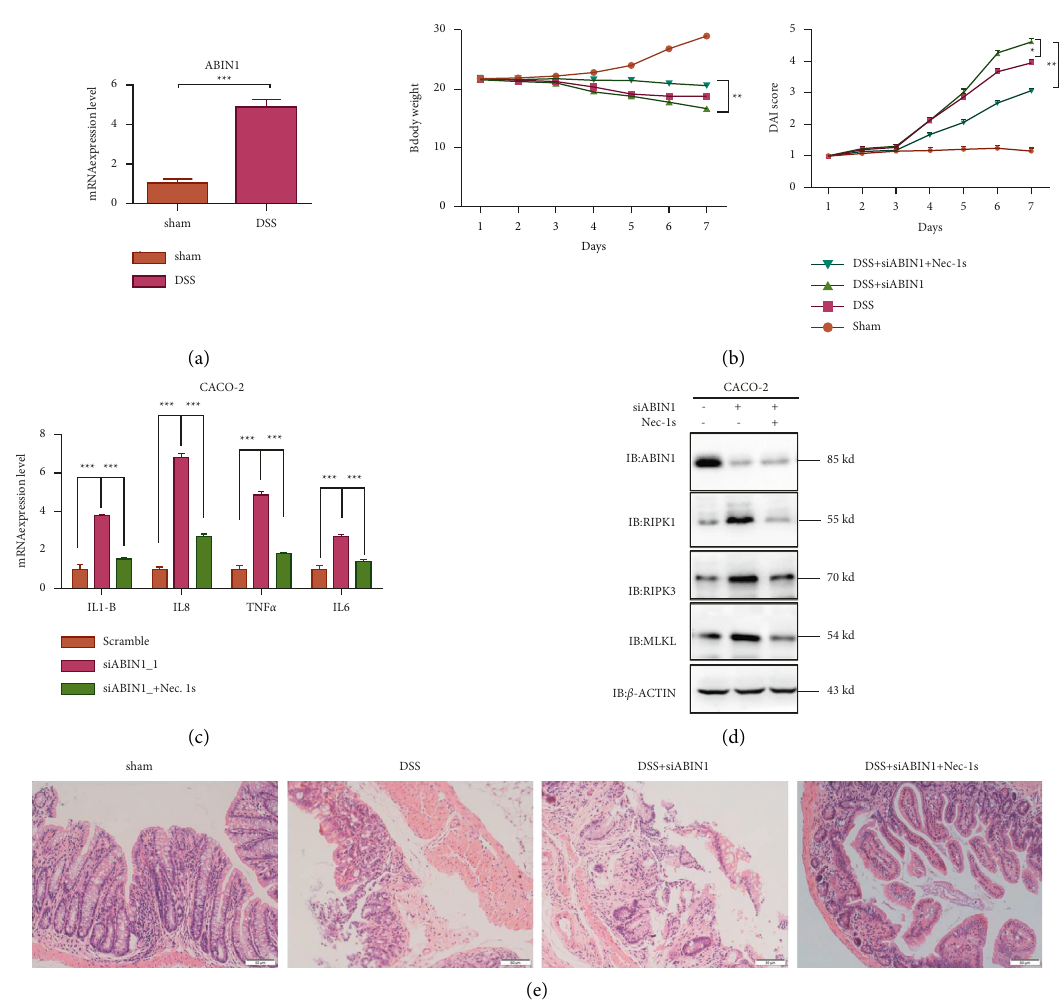
Figure 4: Nec-1s mitigate the necroptosis-associated protein expression and intestinal damage in vivo and in vitro . (a) mRNA expression level of ABIN1 in the DSS-induced colitis model; (b) the body weight and DAI index change in mice on combination treatment with DSS, siABIN1 and Nec-1s for 7 days; (c) mRNA expression level of proinflammatory cytokines under ABIN1 ablation and Nec-1s treatment in CACO-2; (d) necroptosis-associated proteins detection expression level under ABIN1 ablation and Nec-1s treatment in CACO-2; and (e) representative images of four groups’ colonic tissue stained with hematoxylin and eosin (H&E; upper) are shown. The bar represents 50 μ m and two-tailed student’s t -test was performed to assess statistical significance. ∗∗ P < 0 . 01, ∗∗∗ P < 0 .